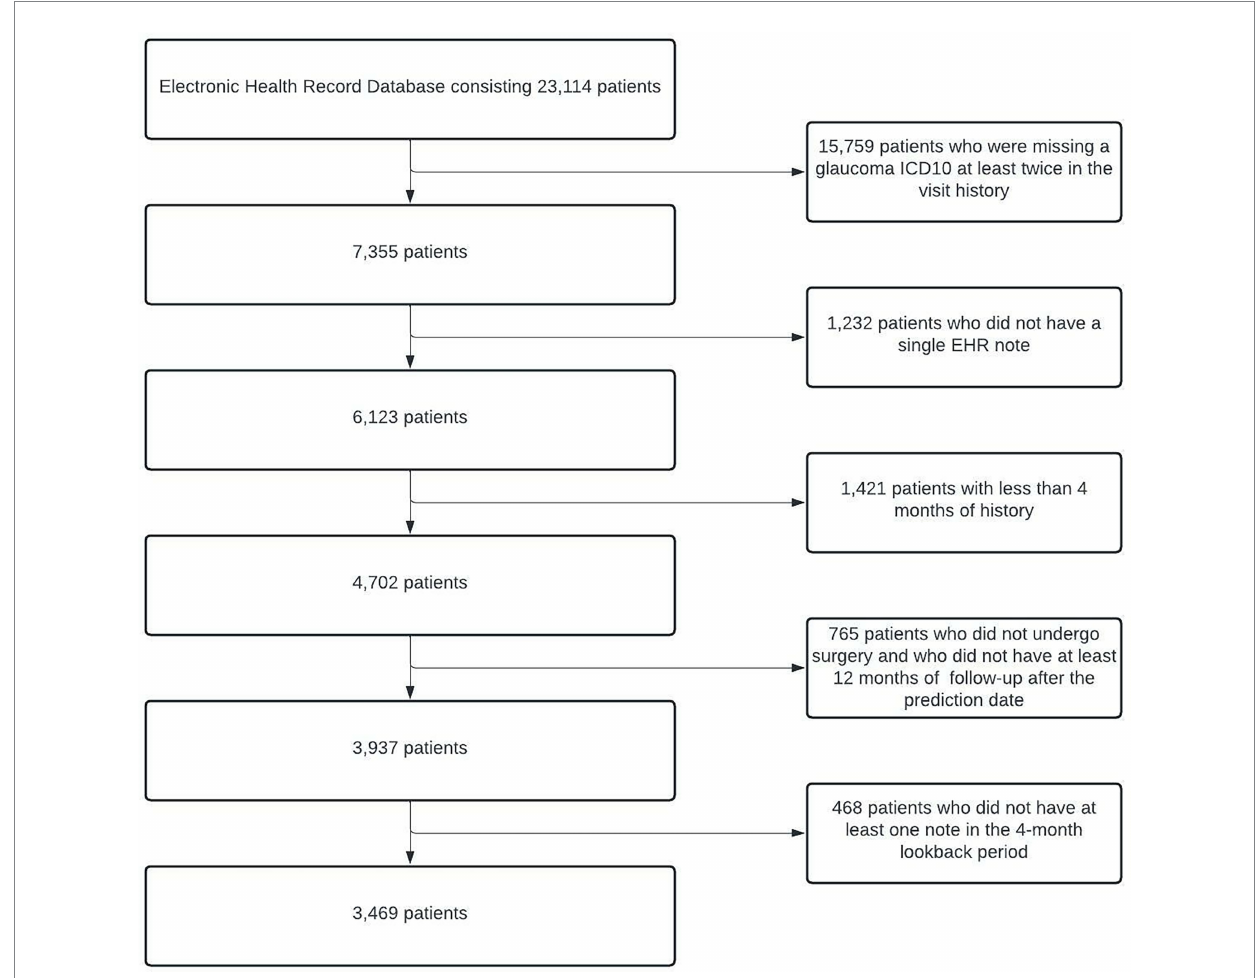
FIGURE 2 Cohort Description and Construction. Flowchart depicting the process of identifying eligible glaucoma patients from EHRs. At the end of all of the processing steps, 3,469 patients were included in the study. EHRs, electronic health